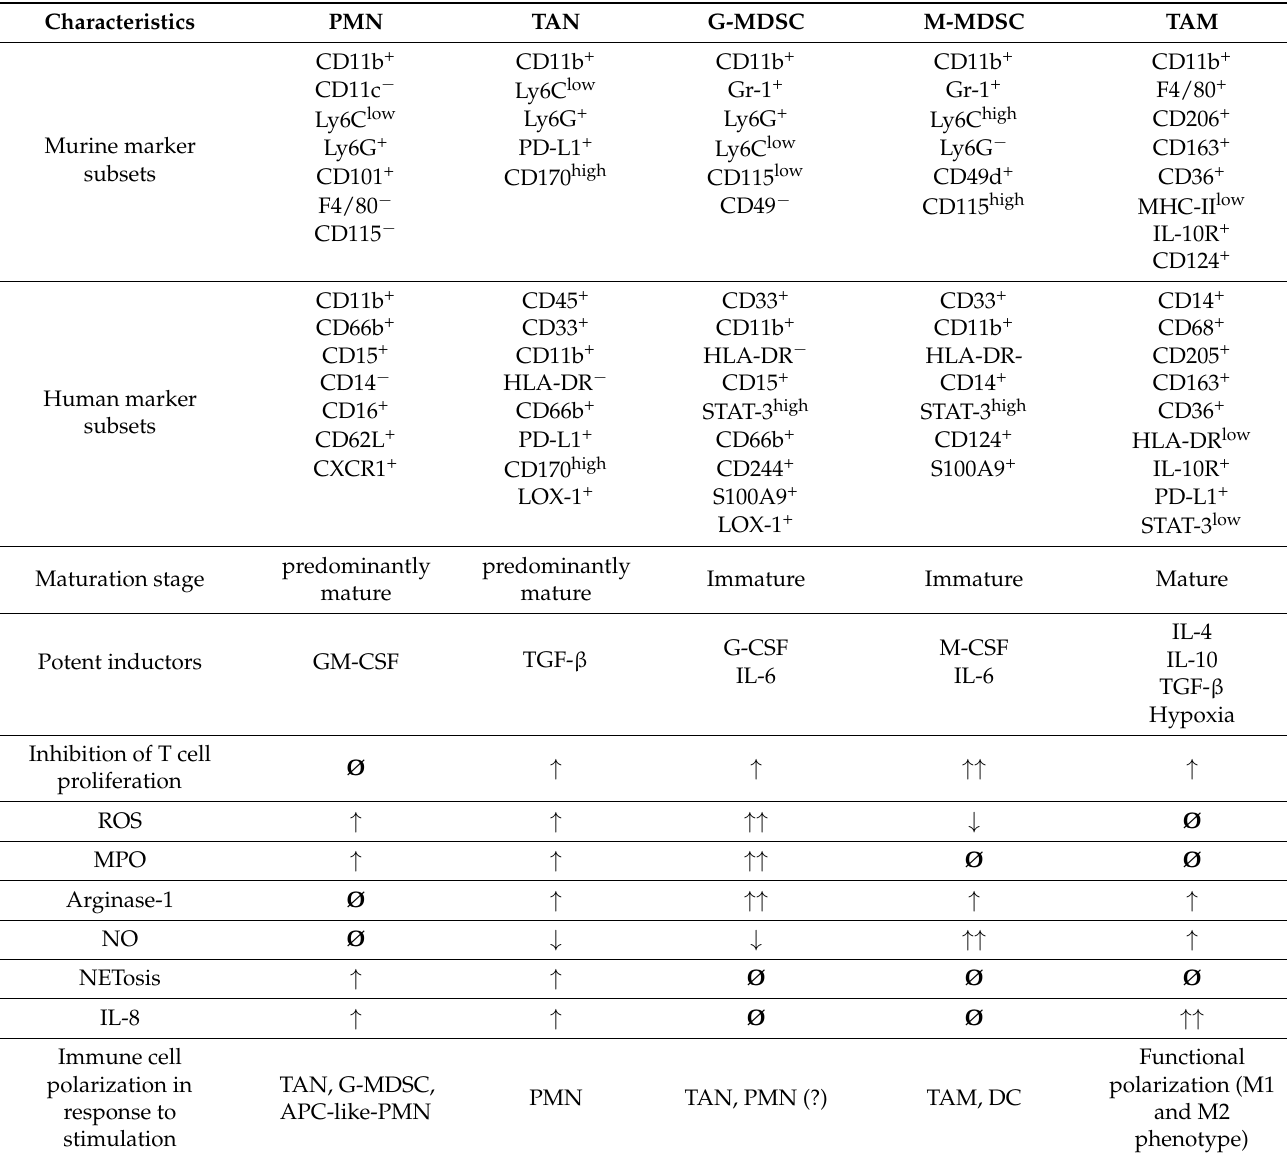
Table 1. Phenotypic definitions and functional characteristics of different myeloid cell types present within solid tumors.